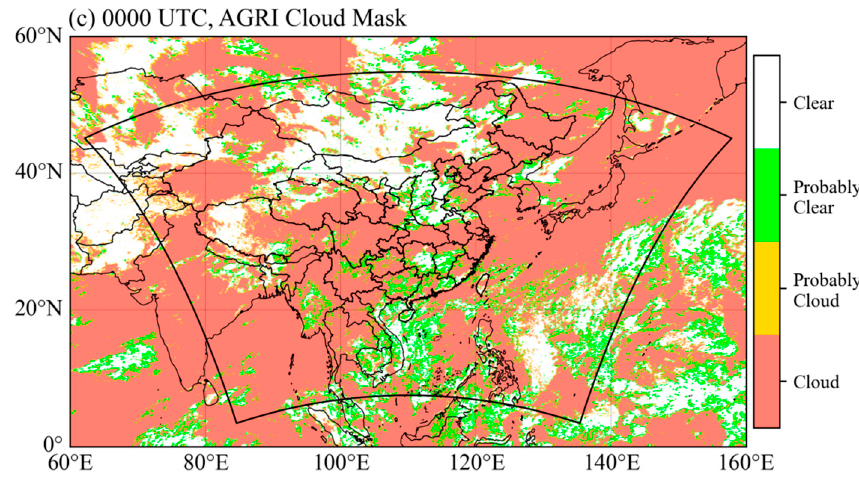
Figure 2. Spatial distributions of the FY-4A AGRI ( a ) channel 9, ( b ) channel 10 brightness temperatures (unit: K), and ( c ) cloud mask products at 0000 UTC on 5 July 2020. The black box indicates the WRF forecast domain.